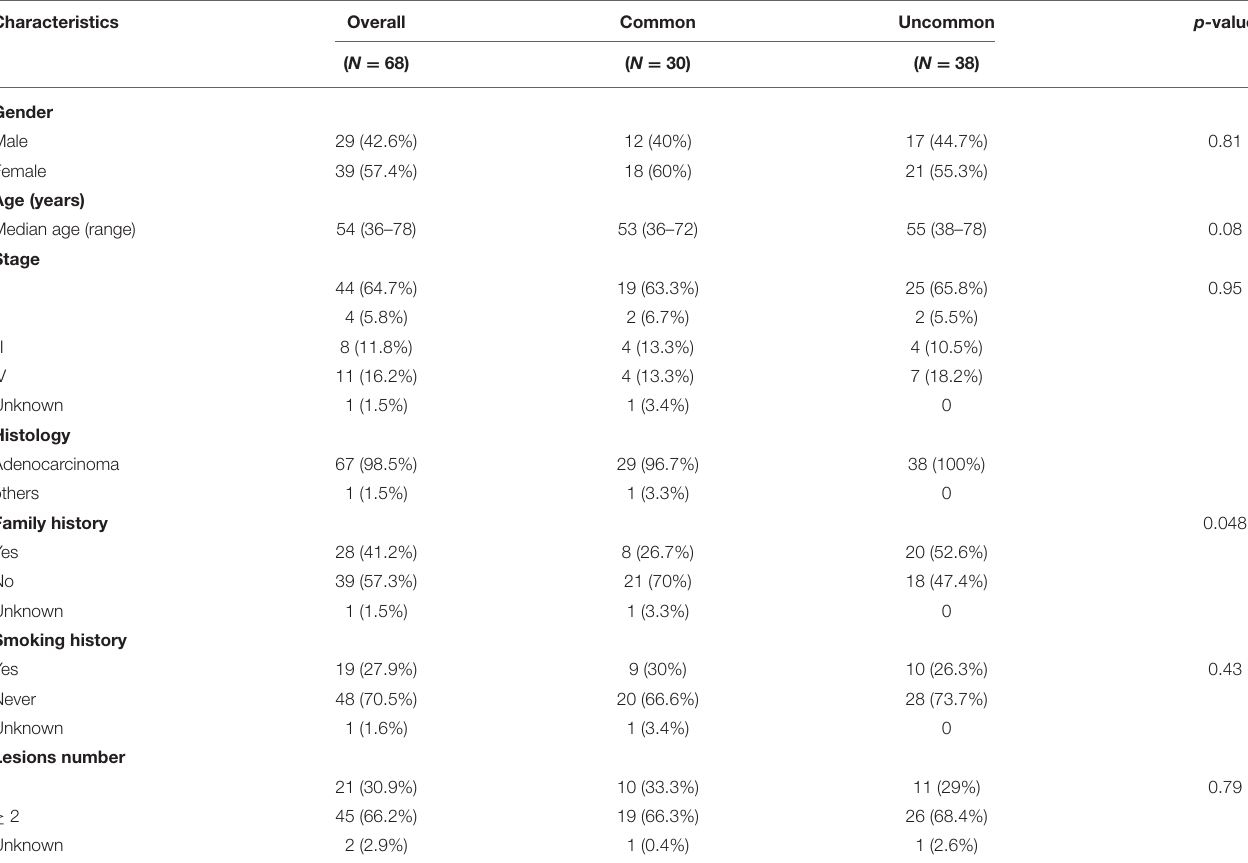
TABLE 2 | Comparison of characteristics of patients from Xuanwei with NSCLC harbouring common and uncommon EGFR mutations. Characteristics